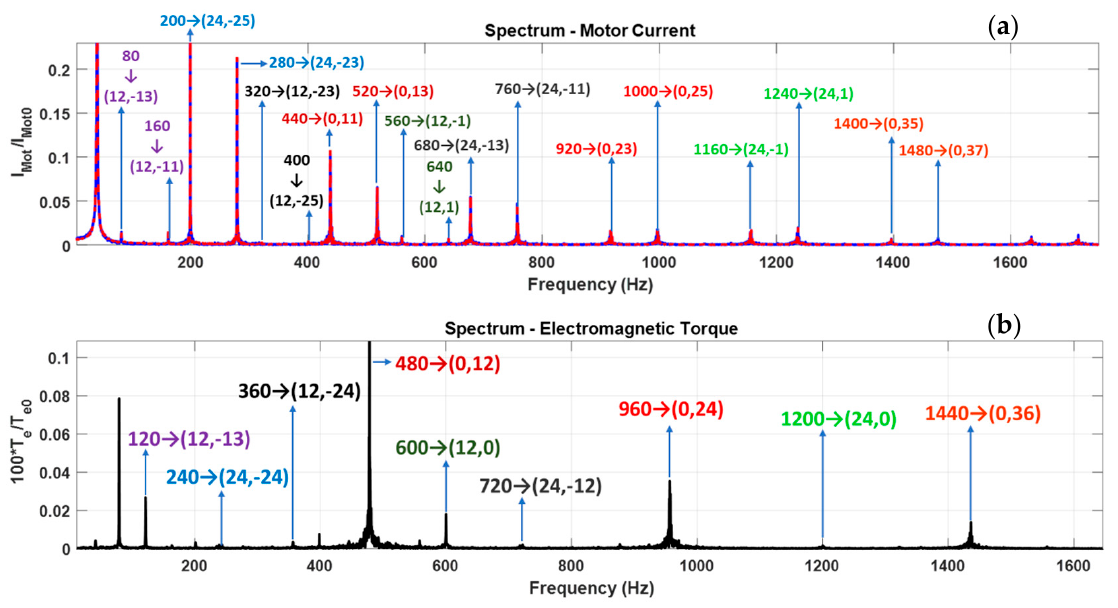
Figure 23. Detailed analysis of motor current and air-gap torque harmonic families of a 6/6-pulse LCI system at 40 Hz: ( a ) motor current spectrum and ( b ) air-gap torque spectrum.